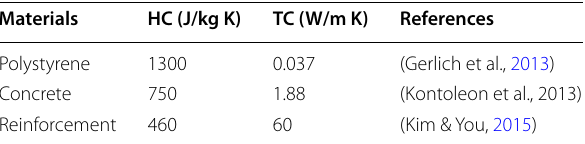
Table 2 FEM material properties.